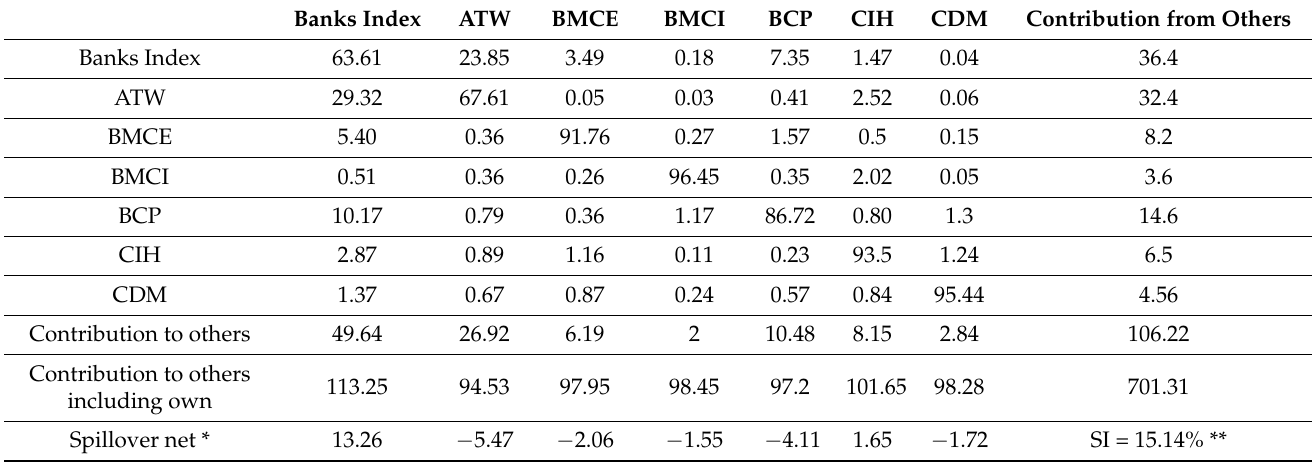
Table 4. Volatility spillover index (pre-crisis period).